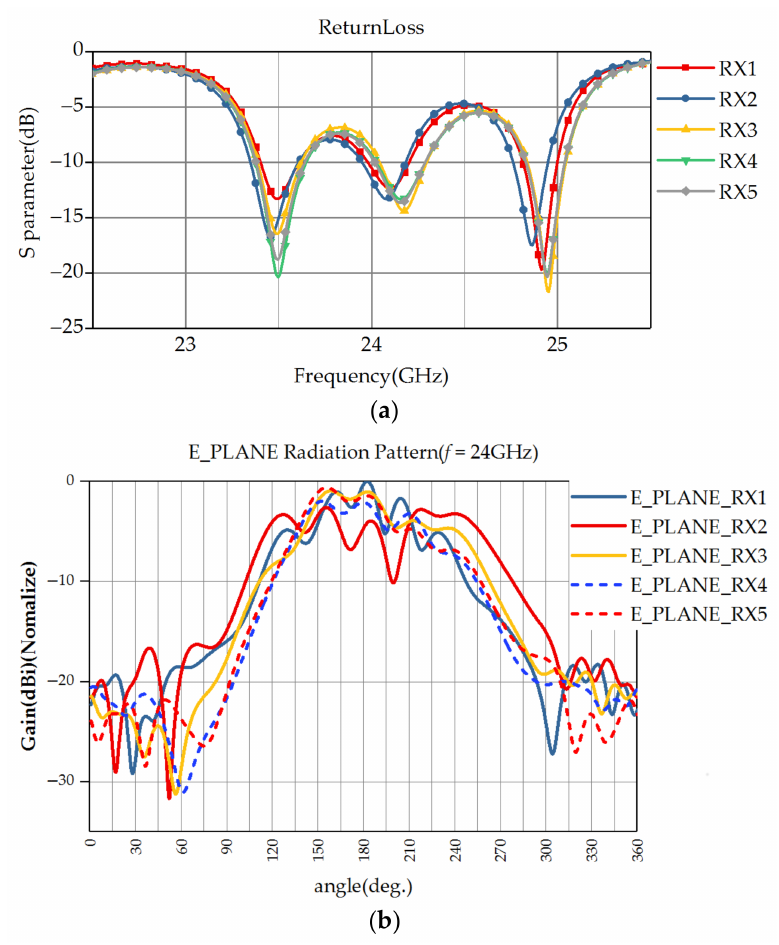
Figure 4. ( a ) Receiving antenna return loss; ( b ) Simulated radiation pattern